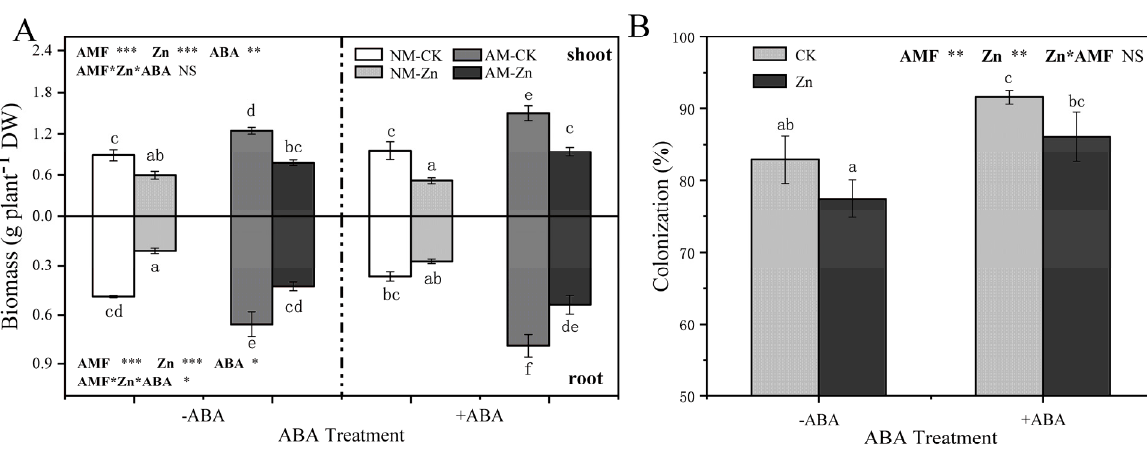
Figure 1. ( A ) Dry weights of shoots and roots of AM plants grown under either control or Zn stress and treated with either 0 (-ABA) or 10 µM ABA (+ABA) application. NM-CK: non-AM inoculation and 0 mg kg − 1 Zn treatment; NM-Zn: non-AM inoculation and 1000 mg kg − 1 Zn treatment; AM-CK: AM inoculation and 0 mg kg − 1 Zn treatment; AM-Zn: AM inoculation and 1000 mg kg − 1 Zn treatment. ( B ) AM colonization of black locust under Zn stress and ABA addition. CK: 0 mg kg − 1 Zn treatment, Zn: 1000 mg kg − 1 Zn treatment. The data show the means ± standard deviations ( n = 3). The different letters above the bars indicate significant differences among the treatments according to Tukey’s test: ( p < 0.05). *, p < 0.05; **, p < 0.01; ***, p < 0.001; NS, not significant.